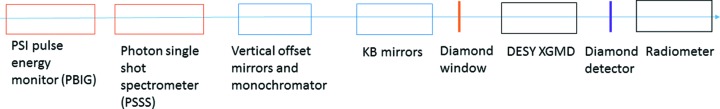
Layout of the experiment.